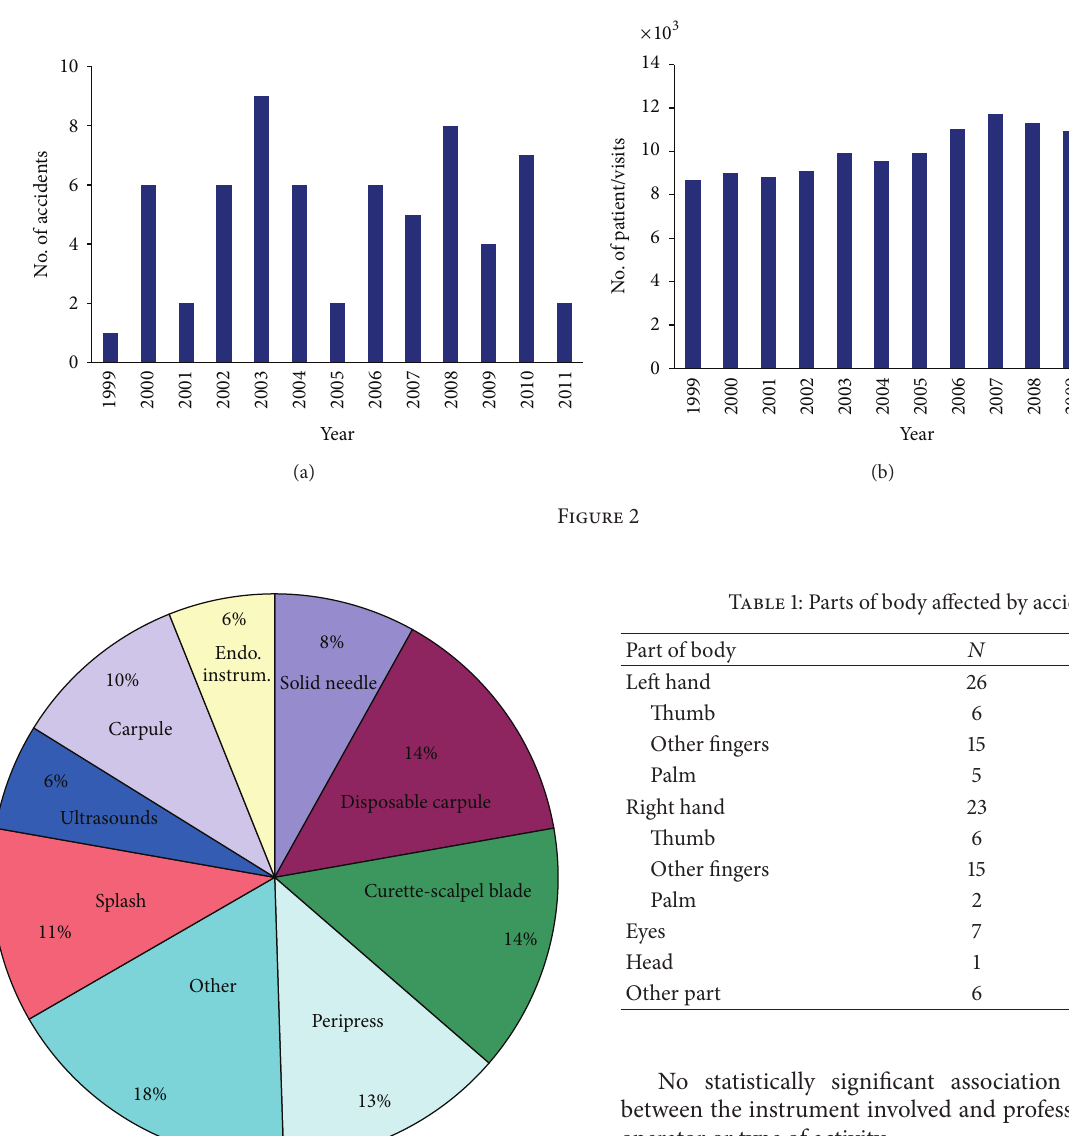
to 11.00 AM ( 𝑛 = 29 ) and from 11.00 AM to 13.00 AM ( 𝑛 = 31 ).